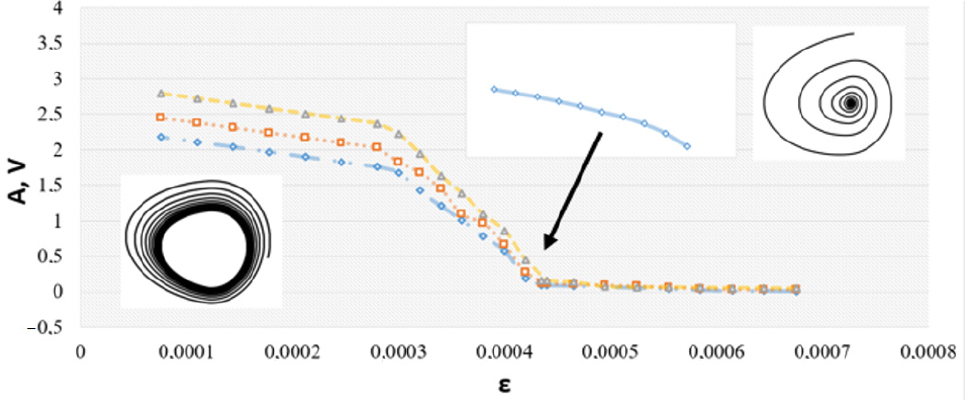
Figure 9. One–parameter bifurcation diagram for an area of 50 × 50 µ m 2 . The arrow shows the increased dependency interval. The blue, orange and yellow dependences are determined by y 1 , y 2 ,